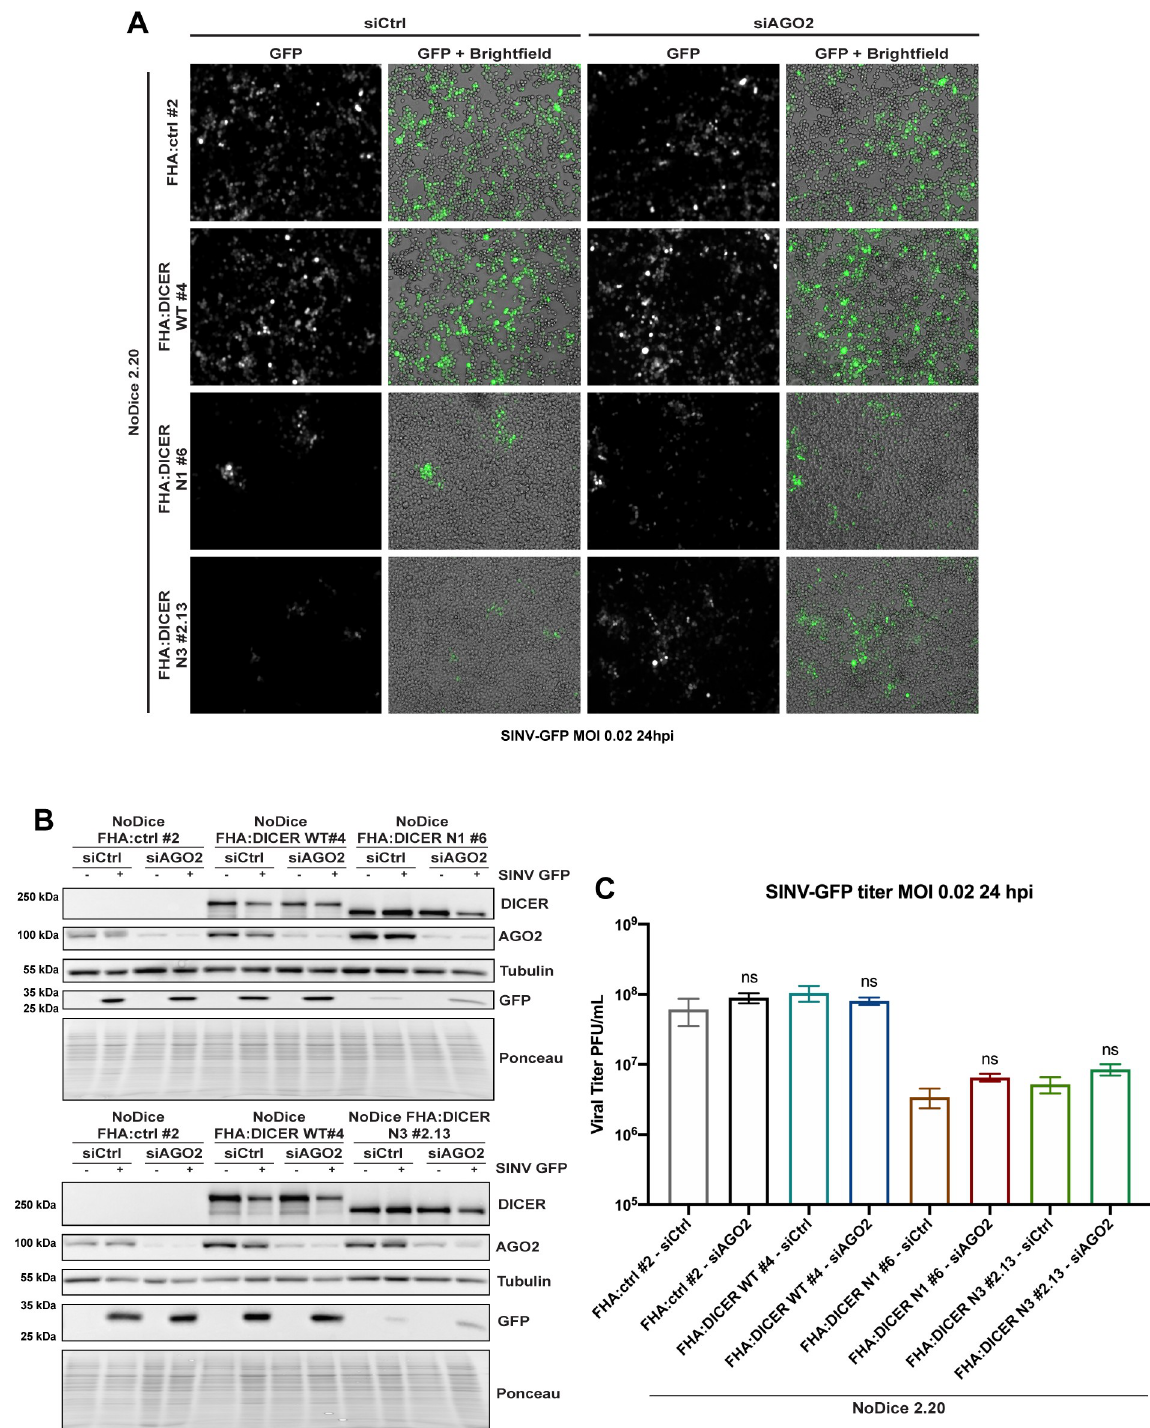
Fig 7. The antiviral effect of helicase-deleted DICER mutants is independent of AGO2. A. GFP fluorescent microscopy pictures of NoDice FHA:ctrl #2, NoDice FHA:DICER WT #4 and NoDice FHA:DICER mutant cell lines treated with two doses of siAGO2 at 20 nM for 48 hours before a 24-hour-SINV-GFP infection at an MOI of 0.02. The left panel corresponds to GFP signal from infected cells and the right panel to a merge picture of GFP signal and brightfield. Pictures were taken with 5x magnification. hpi: hours post-infection. B. Western blot analysis of DICER, AGO2 and GFP expression in SINV-GFP-infected NoDice FHA:ctrl #2, NoDice FHA:DICER WT #4 and NoDice FHA:DICER mutant cell lines shown in A. Cells were treated with two doses of siAGO2 at 20 nM for 48 hours before a 24-hour-SINV-GFP infection at an MOI of